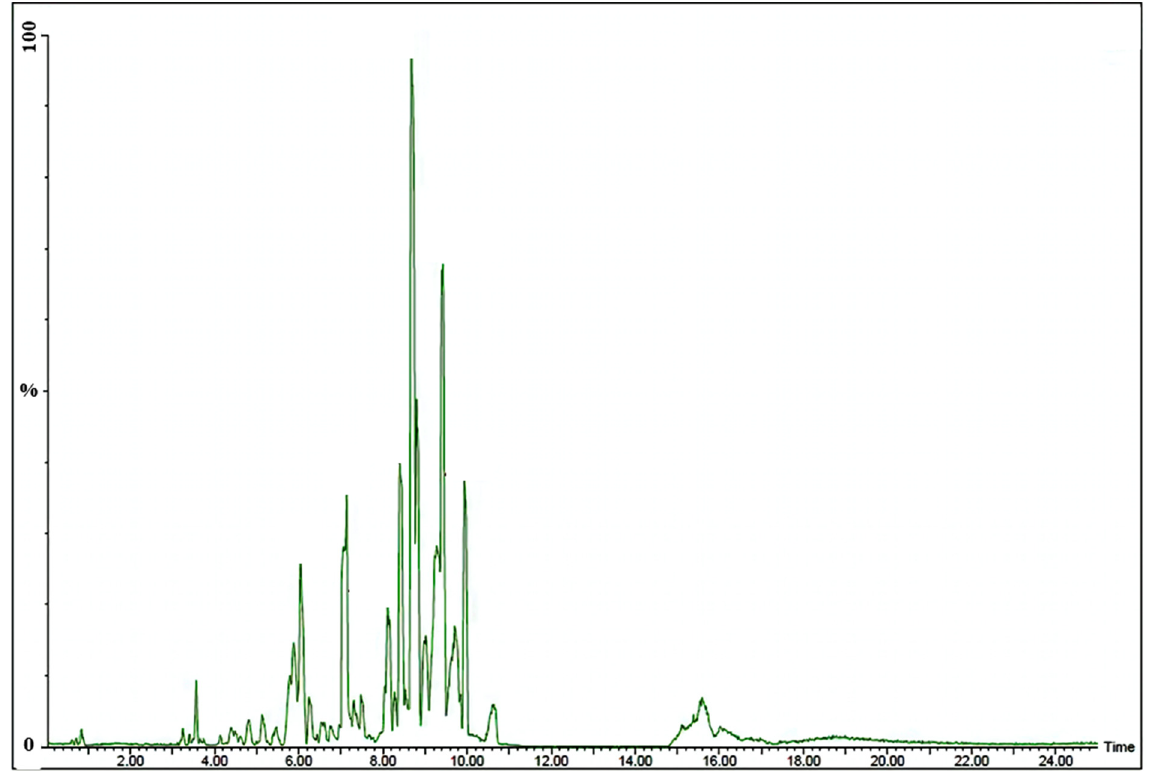
Figure 7. UHPLC Chromatograms of extract of A. terreus AREF023. Table 1. Determination of bioactive compounds in extract of A. terreus AREF023 by LC-ESI-MS (+ion mode).